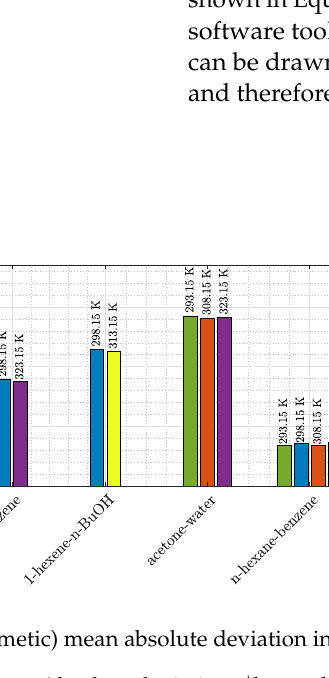
Figure 2. Absolute deviations | h exp − h pred | between results obtained with Matlab program and DDB software